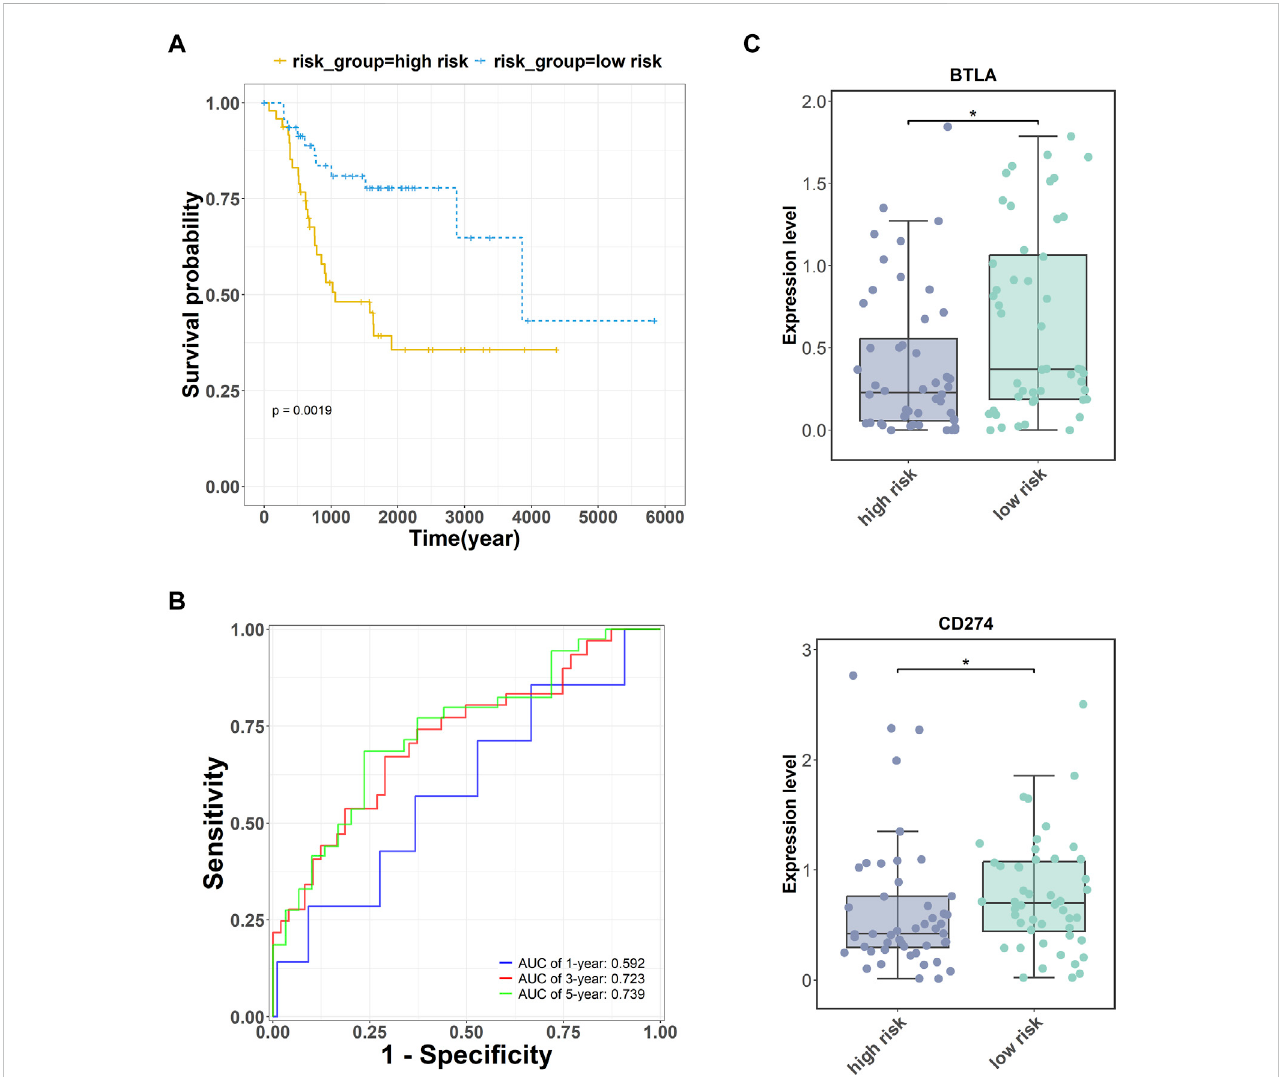
FIGURE 4 Prognosticanalysisof fi vekeytargets(CD4,RUNX2,OMD,COL9A3,andJUN)inOS. (A) Thesurvivalanalysisofthese fi vegenes. (B) Thereceiveroperator characteristic (ROC) curve of these fi ve genes. (C) The expression of immune checkpoints BTLA and PDL1 (CD274) were measured in the high- and low-risk groups. * p <